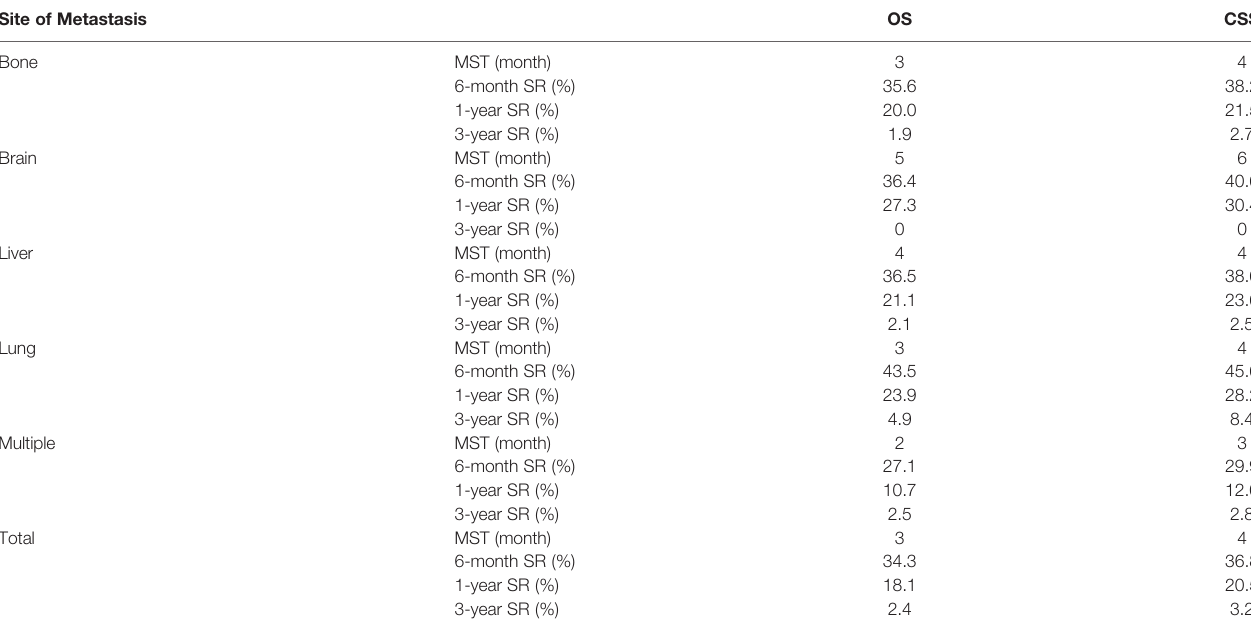
TABLE 4 | Prognostic analysis in different population. Site of Metastasis